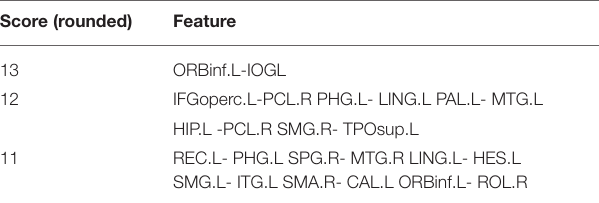
FIGURE 5 | The optimal amount of SVM classifiers. TABLE 2 | The features with higher